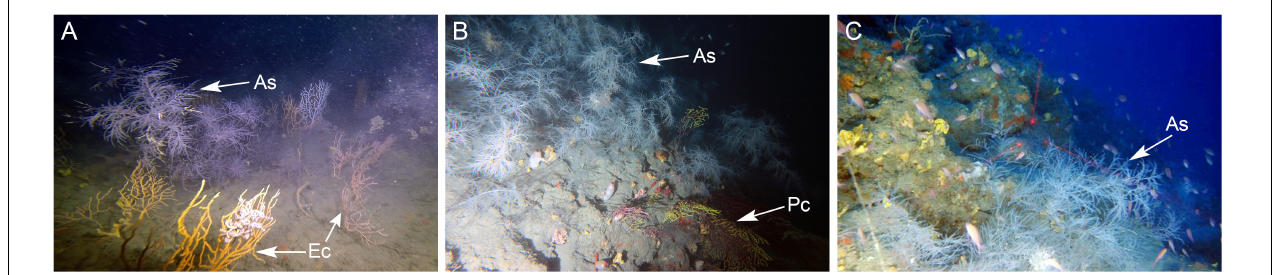
FIGURE 2 | Populations of Antipathella subpinnata on the shoals near (A) Portofino at 67 m depth, (B) Bordighera at 63 m depth and (C) Savona at 70 m depth. Colonies of A. subpinnata (As) and the sympatric gorgonians Paramuricea clavata (Pc) and Eunicella cavolini (Ec) are indicated with